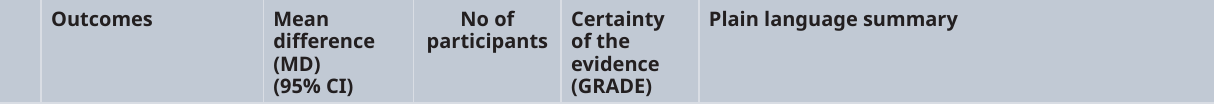
Table 5. Summary of findings for care provided by NPHWs for non-communicable disease management.